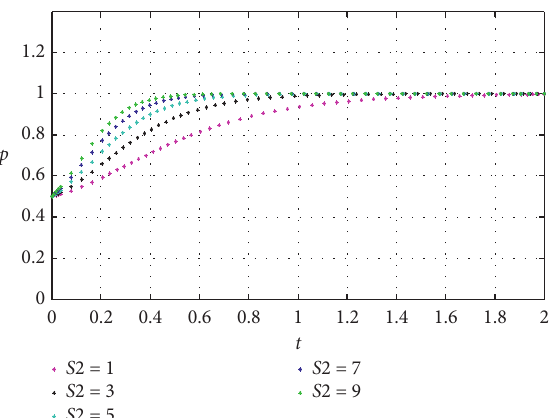
Figure 12: Evolutionary trajectory of ESCOs’ behavior under different S . 2